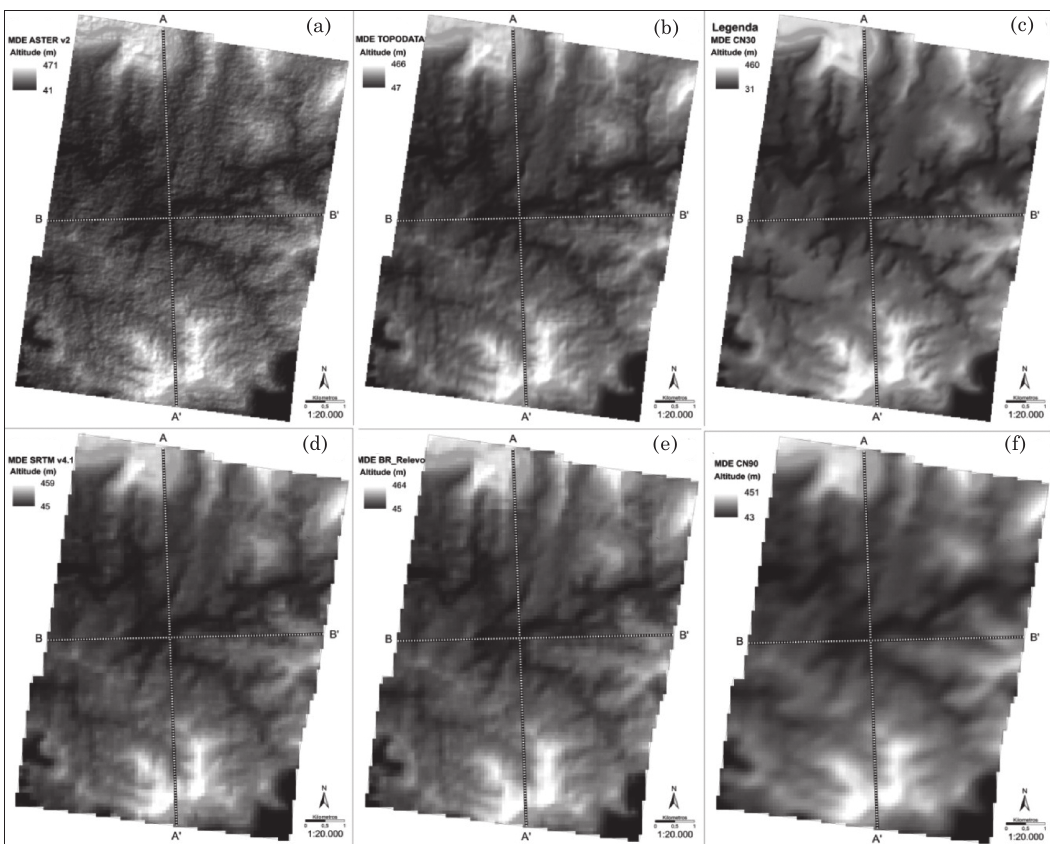
Figura 1. Transectos e modelos digitais de elevação utilizados: (a) ASTER GDEM v2; (b) TOPODATA; (c) MDE CN30; (d) SRTM v4.1; (e) BR_Relevo; e (f)